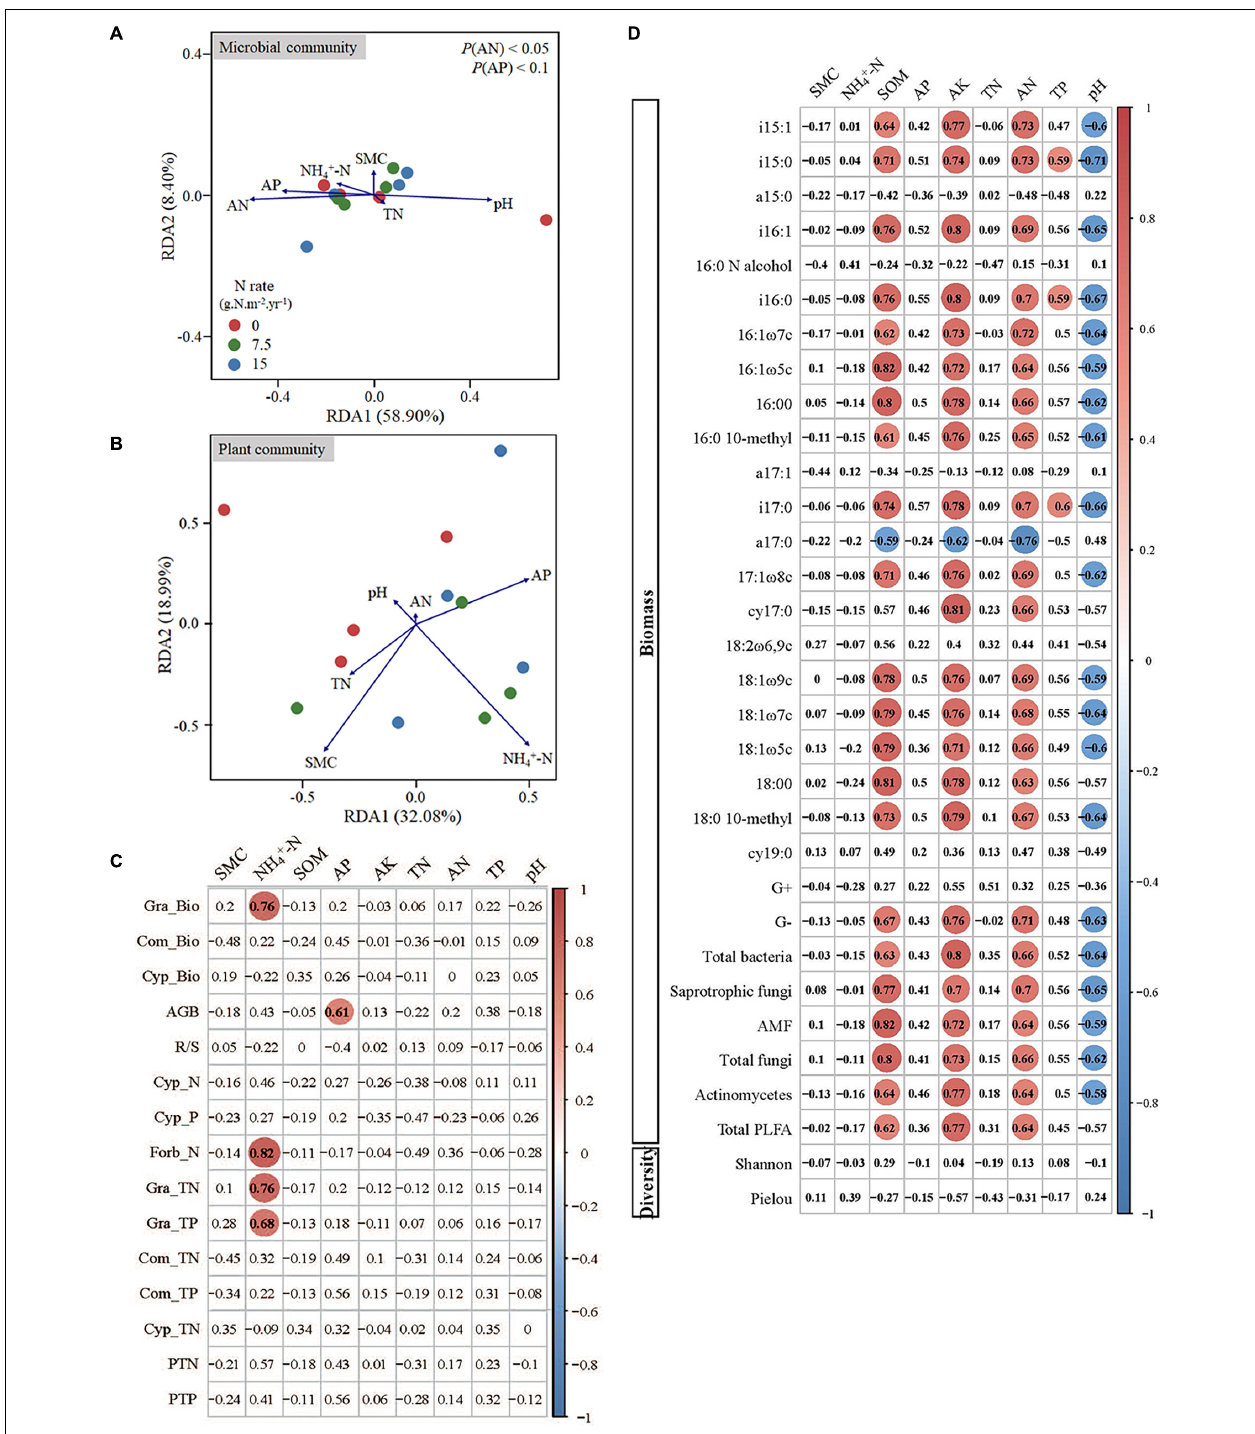
FIGURE 4 | Redundancy analysis biplot for the correlation of plant (A) and microbial community (B) with soil properties, and the correlations between soil properties and plant traits (C) and microbes (D) . Red circles in (C) and (D) indicate significant positive correlations, and blue circles indicate significant negative correlations. SMC indicates the soil moisture content; SOM indicates the soil organic matter content; AP indicates the soil available P; AK indicates the soil available potassium; TN indicates the soil total N content; AN indicates the soil available N; TP indicates the soil total P content; Gra indicates Gramineae; Com indicates Compositae; Cyp indicates Cypositae; AGB indicates the total aboveground biomass; -Bio indicates the aboveground biomass; R/S indicates the ratio of root to shoot biomass; -N indicates the concentration of total nitrogen; -P indicates the concentration of total phosphorus; -TN indicates the total nitrogen content; -TP indicates the total phosphorus content; PTN indicates the total nitrogen content of all aboveground biomass; PTP indicates the total phosphorus content of all aboveground biomass.